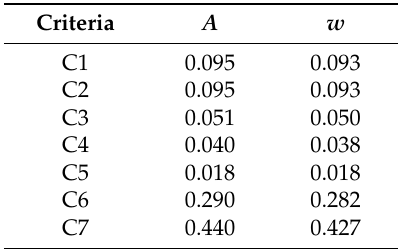
Table 10. Final relative weightage for each criteria (Expert 1).